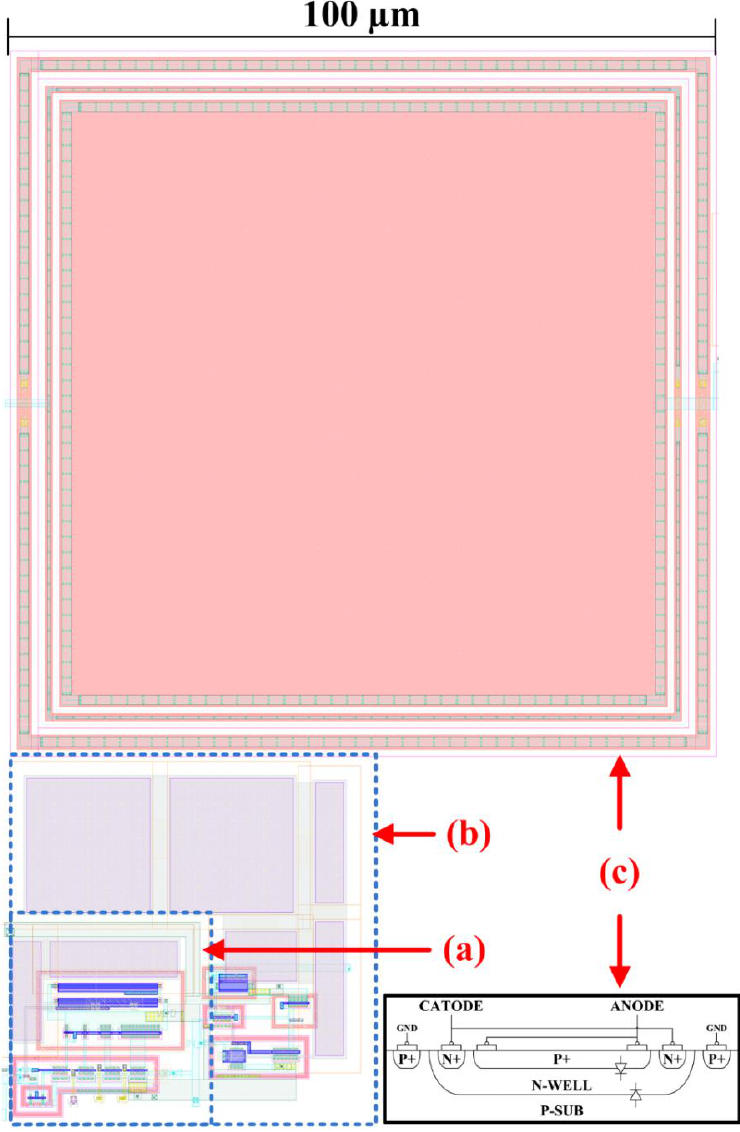
Figure 3. Overall layout of the optoelectronic sensing SoC: ( a ) The TCG stage; ( b ) The CVC stage; ( c ) The PD based on a PNP junction and its cross section.